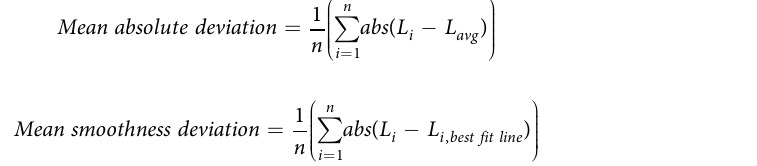
determined according to equation (2) and (3).